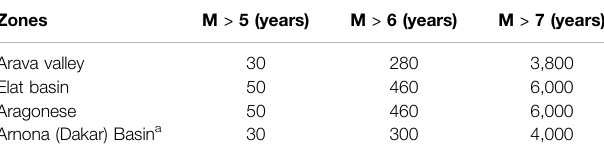
TABLE 5 | Repeat time (by magnitude in years) of strong earthquakes in the southern Arava Valley and Gulf of Elat – Aqaba (GEA) basins according to Building Code SI-413 (data and terminology after Shapira and Hofstetter,